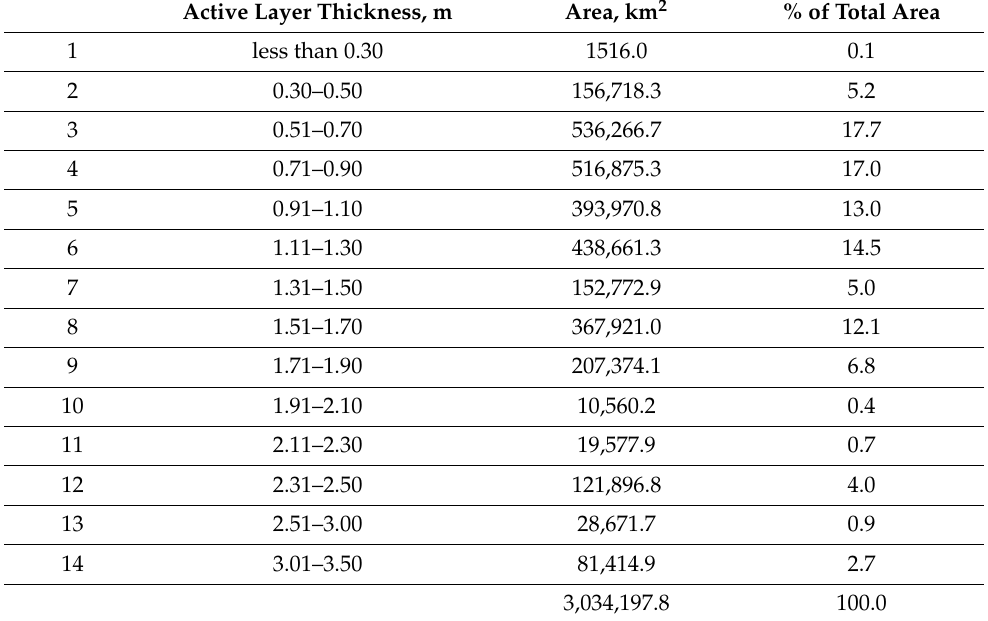
Table 2. Spatial distribution of active layer